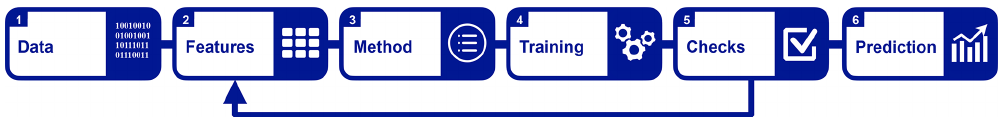
Figure 1. Schematic of our machine learning workflow: the raw input data are converted into molecular representations (referred to as features in this figure). We then set up and train a machine learning method. After evaluating its performance in step 5, we may adjust the features. Once the machine learning model is calibrated and trained, we make predictions on new data.